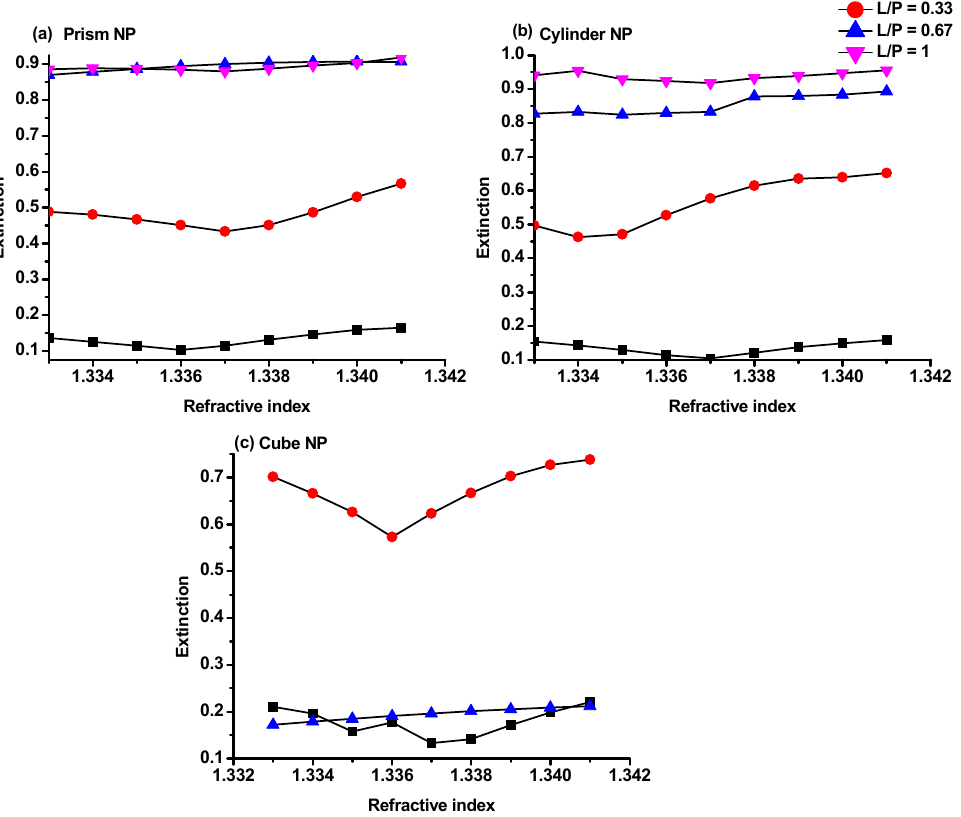
Figure 6. Extinction intensity of the hybrid Au-G nanostructure with ( a ) prism; ( b ) cylindrical; and ( c ) cubic NPs at different L/P ratios as a function of refractive index.